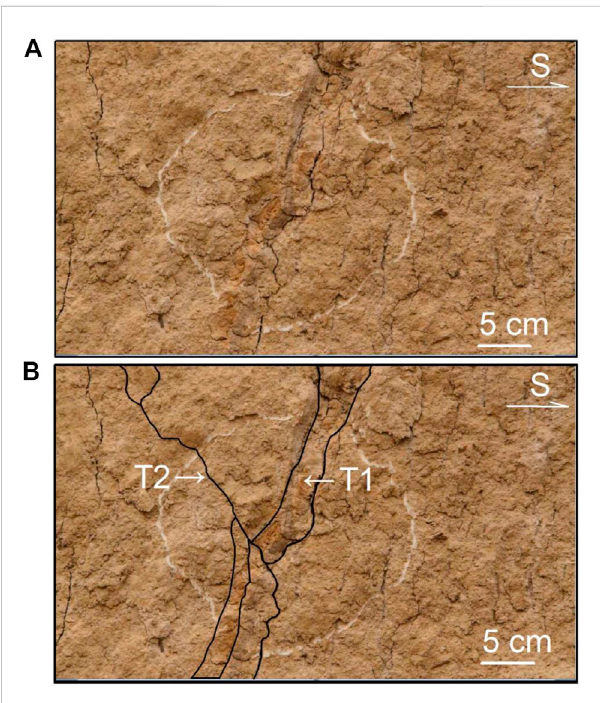
FIGURE 7 (A) Photograph and (B) interpreted sketch of the offset relationship between the two events. T1: previous event; T2: later event. The solid black line represents the interpreted fi ssure locations.